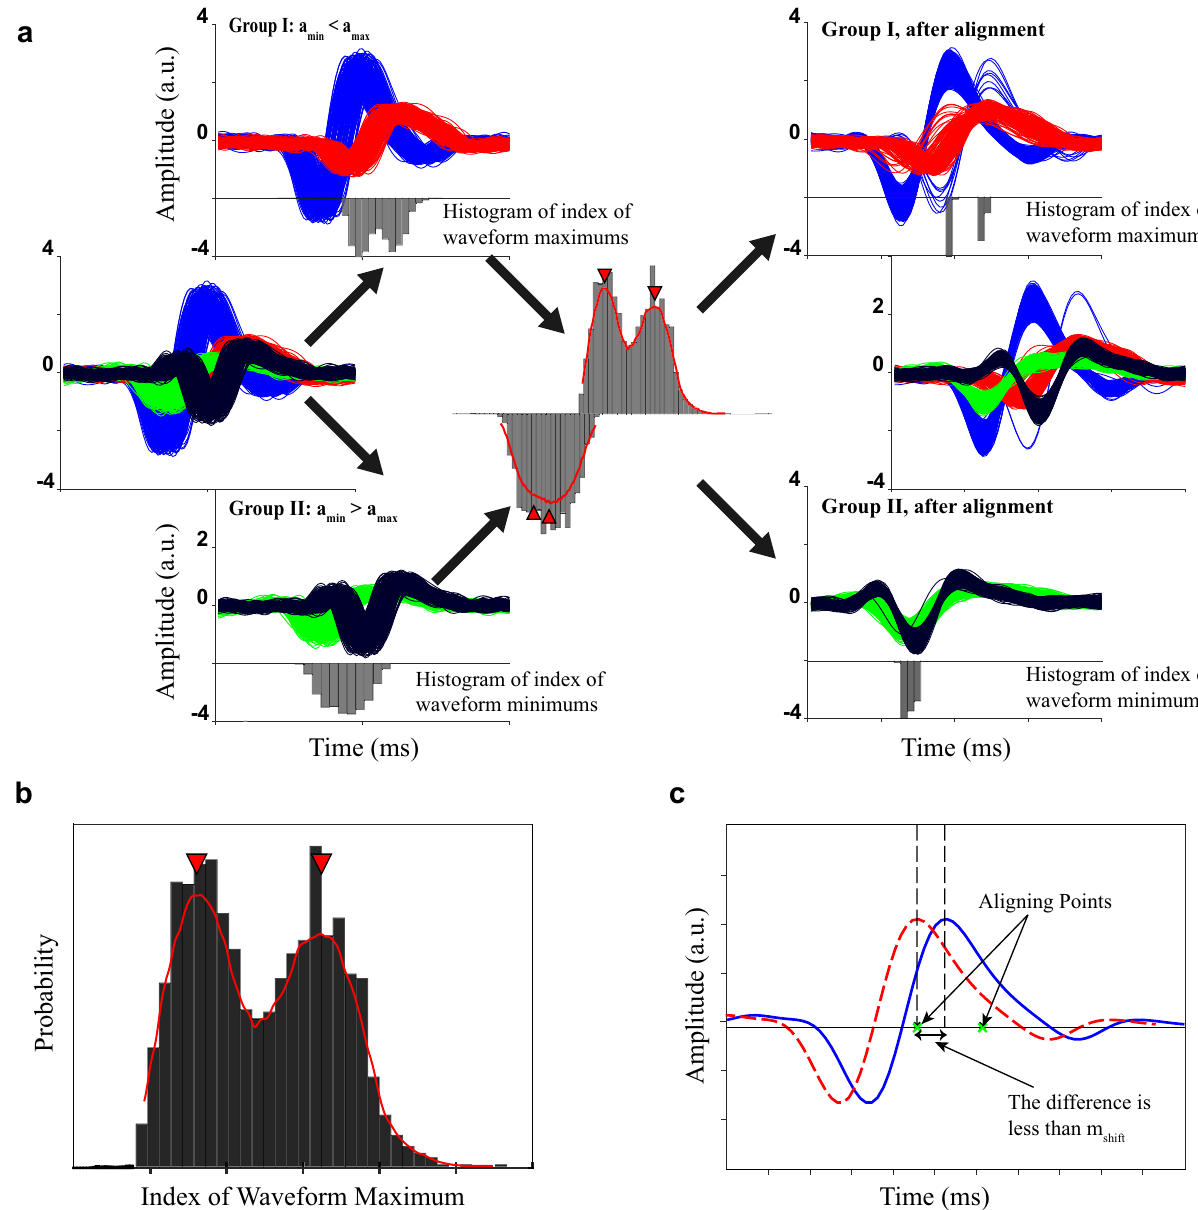
Figure 1. An intuitive example of the proposed multi-point alignment procedure. ( a ) Alignment of synthesized waveforms. The y-axis shows amplitude with arbitrary unit (a.u.). The synthesized waveforms are designed to form four distinct shapes. The waveforms are grouped according to the amplitude of their maximums and minimums. Then, the peak of the smoothed histogram of extremum indices is found, as the aligning points. Finally, the waveforms are aligned regarding the aligning points. ( b ) The histogram of the peak locations in waveforms. The smoothed cubic spline fitted to the histogram is shown by the red line. The locations of two local maximums are indicated using red triangles. ( c ) The blue solid line is the original waveform. The aligning points corresponding to the local maximums in ( b ) are also depicted using green crosses. If the difference between the peak location of the waveform and the nearest aligning point is less than m shift , the waveforms are aligned by an appropriate shift, forming the aligned waveform illustrated by dashed red